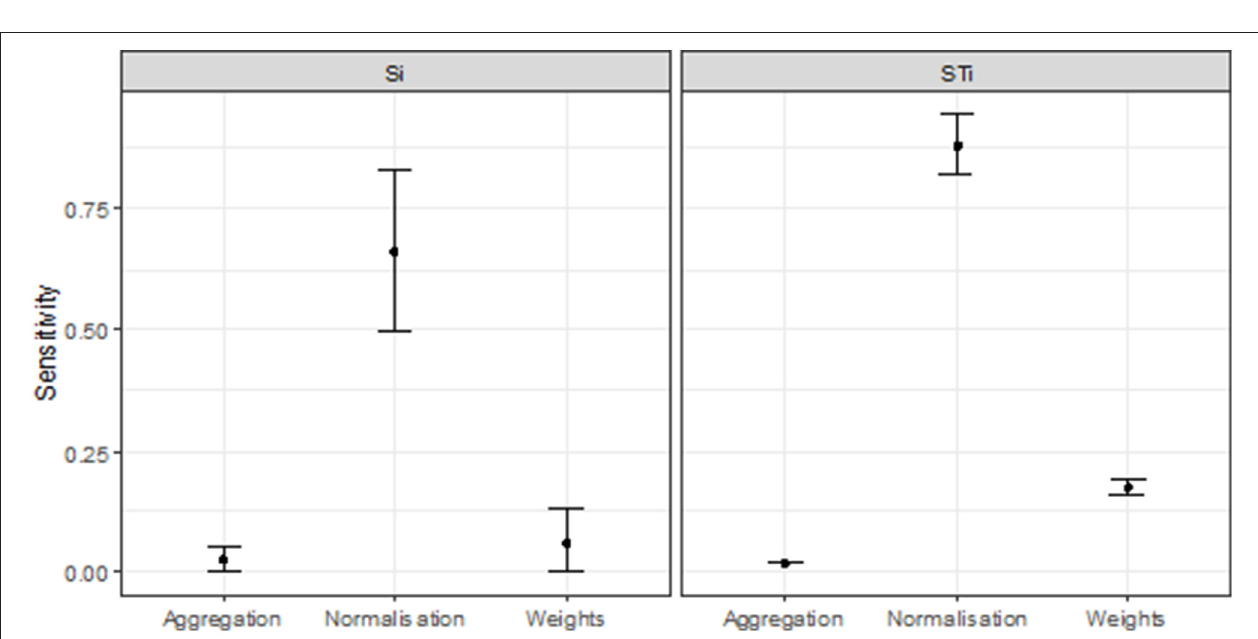
FIGURE 7 | First order (S i ) and total order (S Ti ) sensitivity indices of input assumptions plotted as mean (dot) and 90% confidence intervals by bootstrapping.